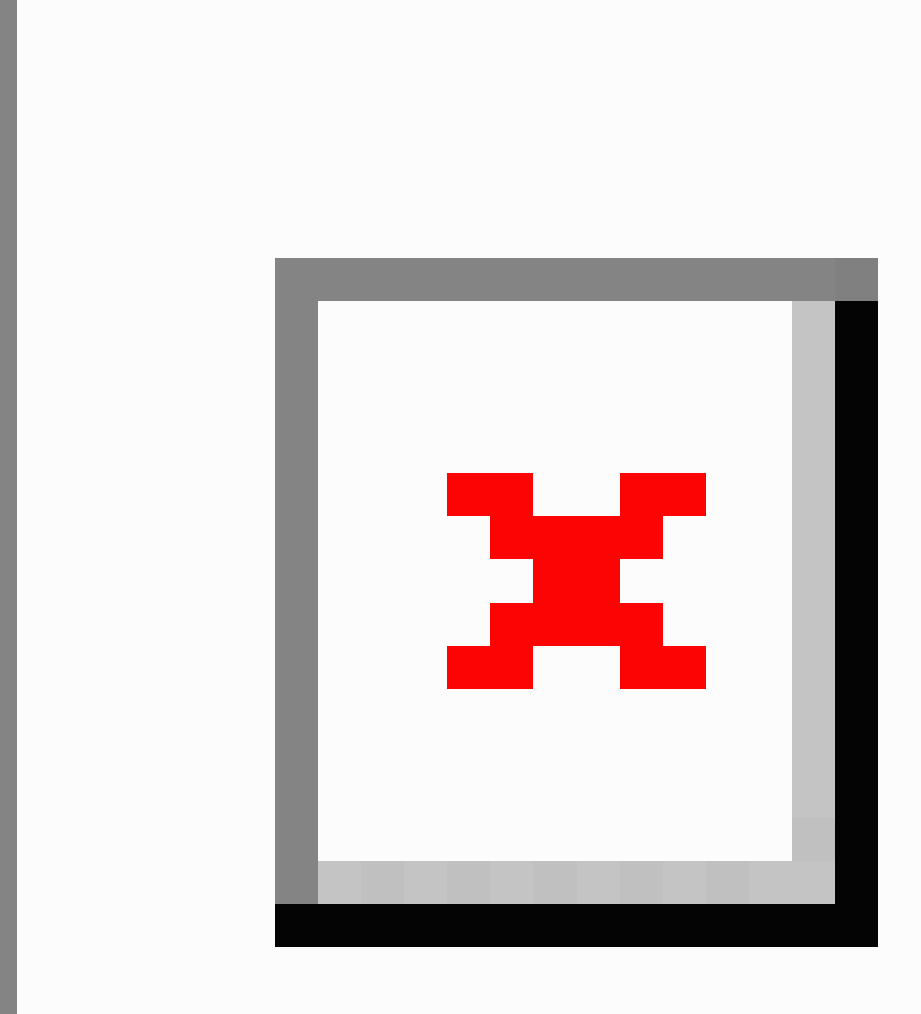
Figure 3. Distribution of scores: